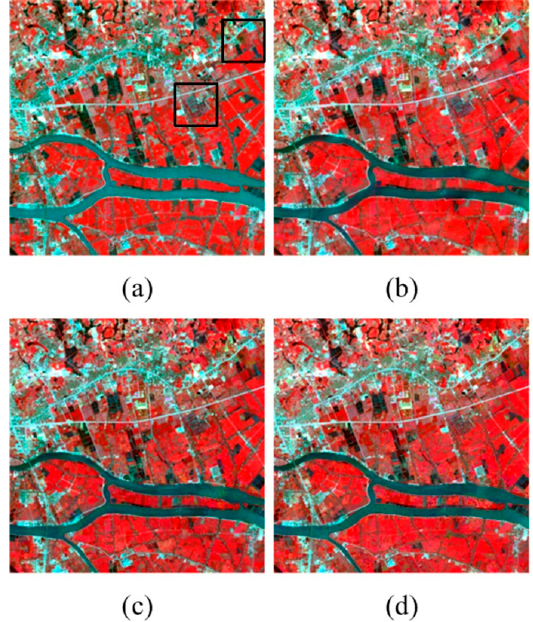
Figure 9. The ( a ) actual image acquired on 13 September 2000 and its predictions by ( b ) STBDF-II, ( c ) STARFM, and ( d ) ESTARFM.